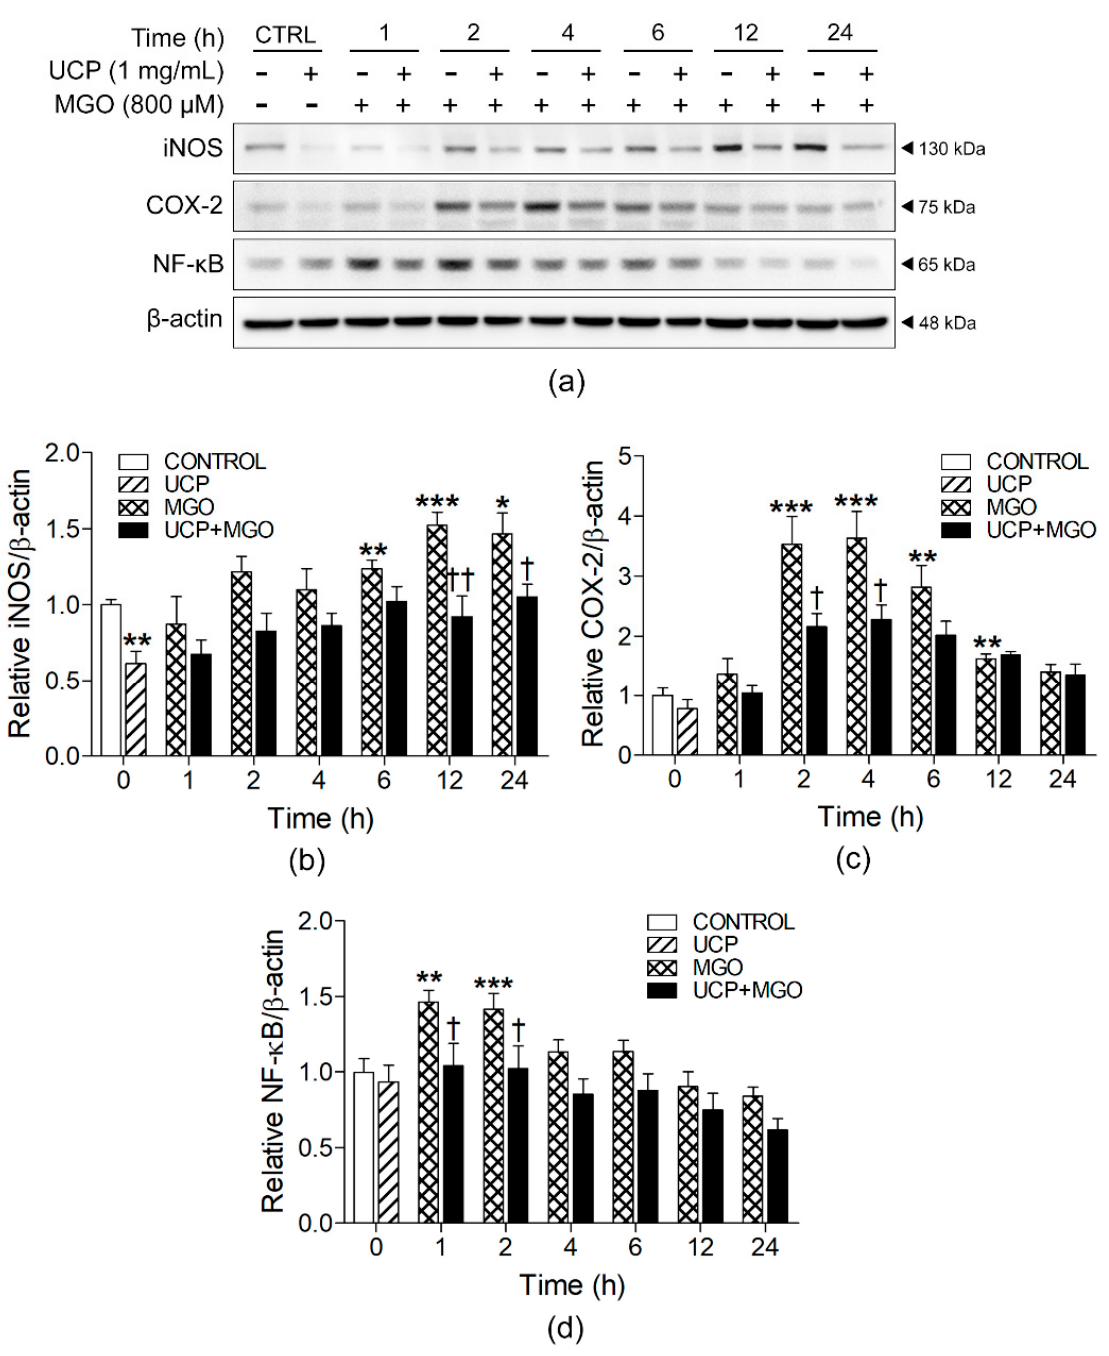
Figure 6. Effects of UCP pretreatment on MGO-induced cell inflammatory signaling protein expression. ( a ) Representative Western blot protein bands. ( b ) Relative ratios of iNOS/ β -actin and ( c ) COX-2/ β -actin. ( d ) The ratios of NF- κ B/ β -actin. Data are presented as mean ± SEM. *, p < 0.05; **, p < 0.01; and ***, p < 0.001, when compared with each treated group; †, p < 0.05; and ††, p < 0.01, when compared with MGO challenged group at the same time